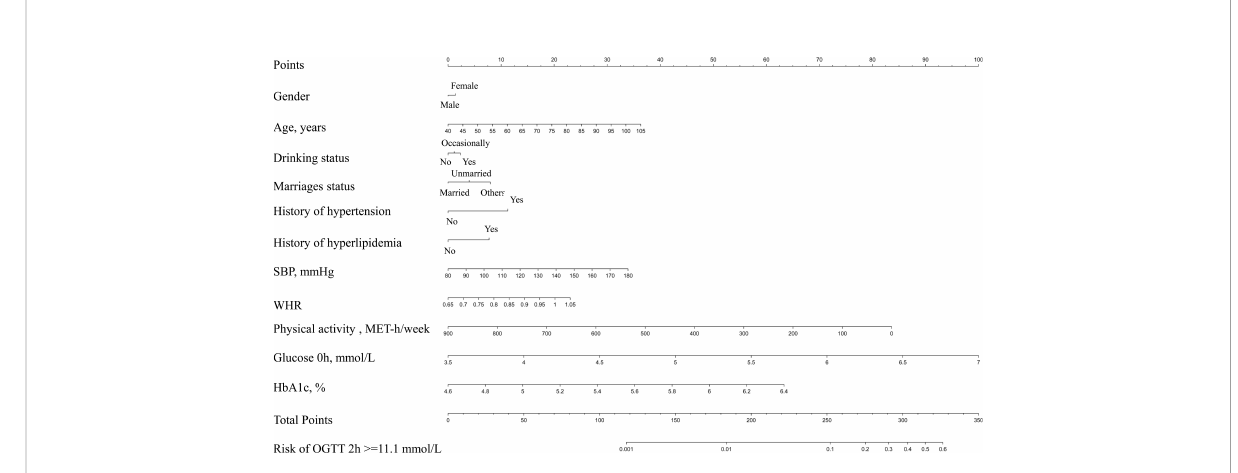
FIGURE 2 Nomogram for participants with isolated high 2-hour plasma